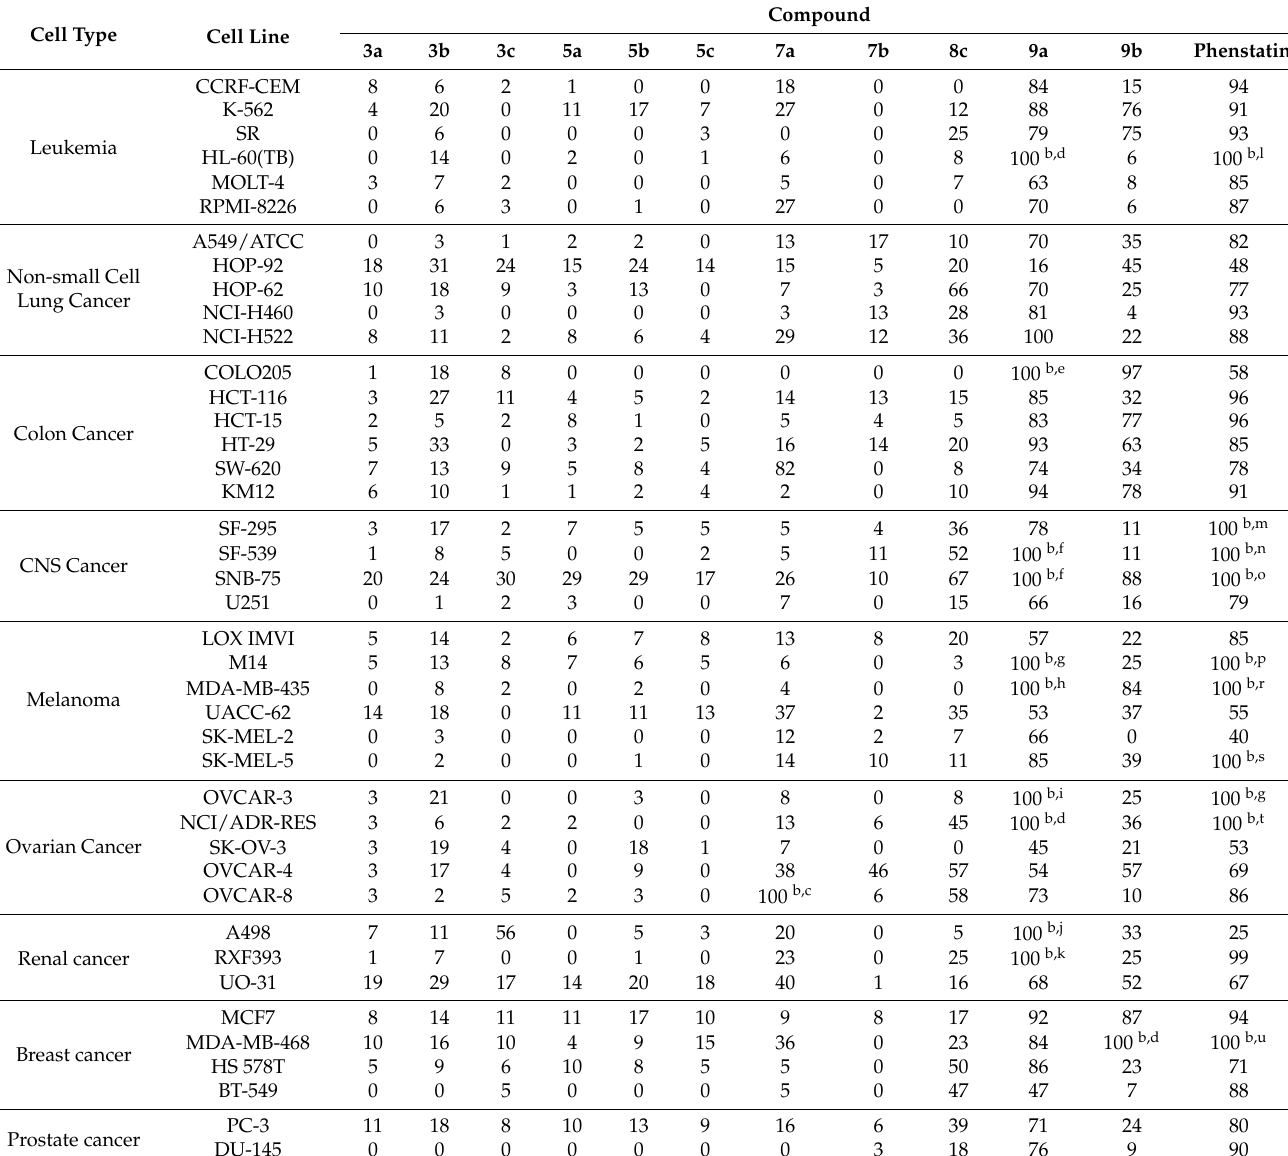
Table 3. Results of the in vitro growth inhibition (GI%, 10 − 5 M) caused by compounds 3a , b , 5a–c , 7a , b , 8c and 9a , b against human cancer cell lines in the single-dose assay a